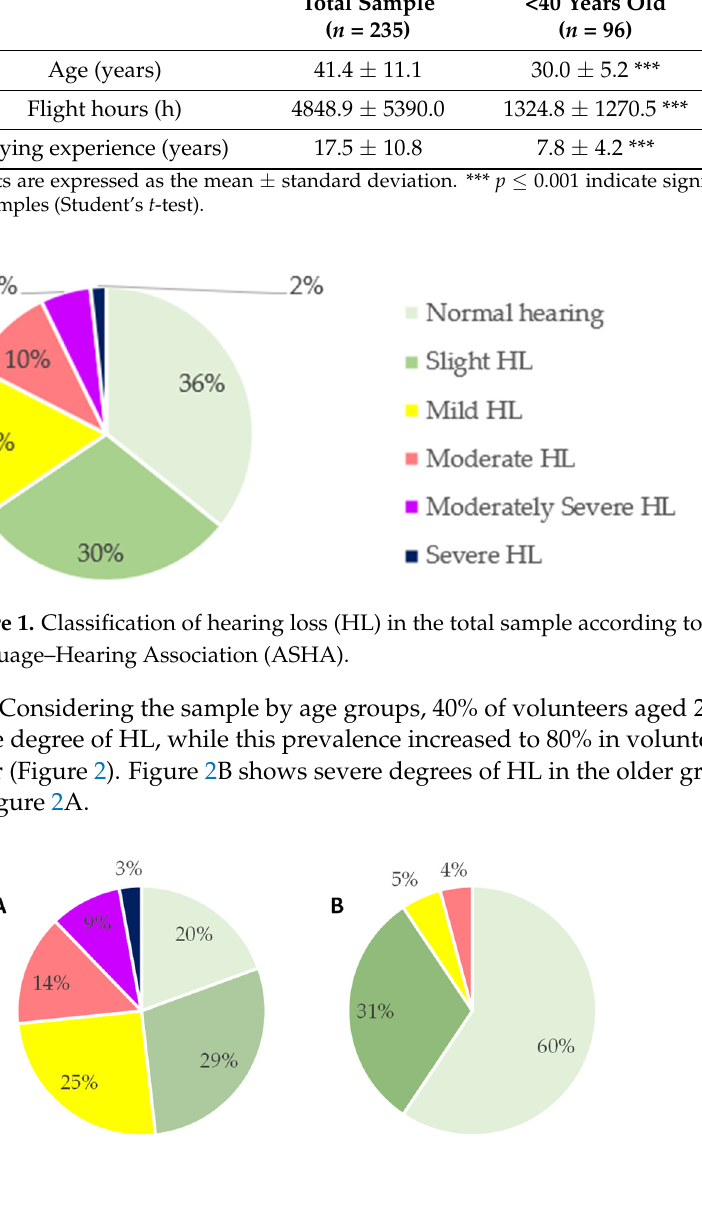
Table 1. Description of the total sample and sorted by age groups.